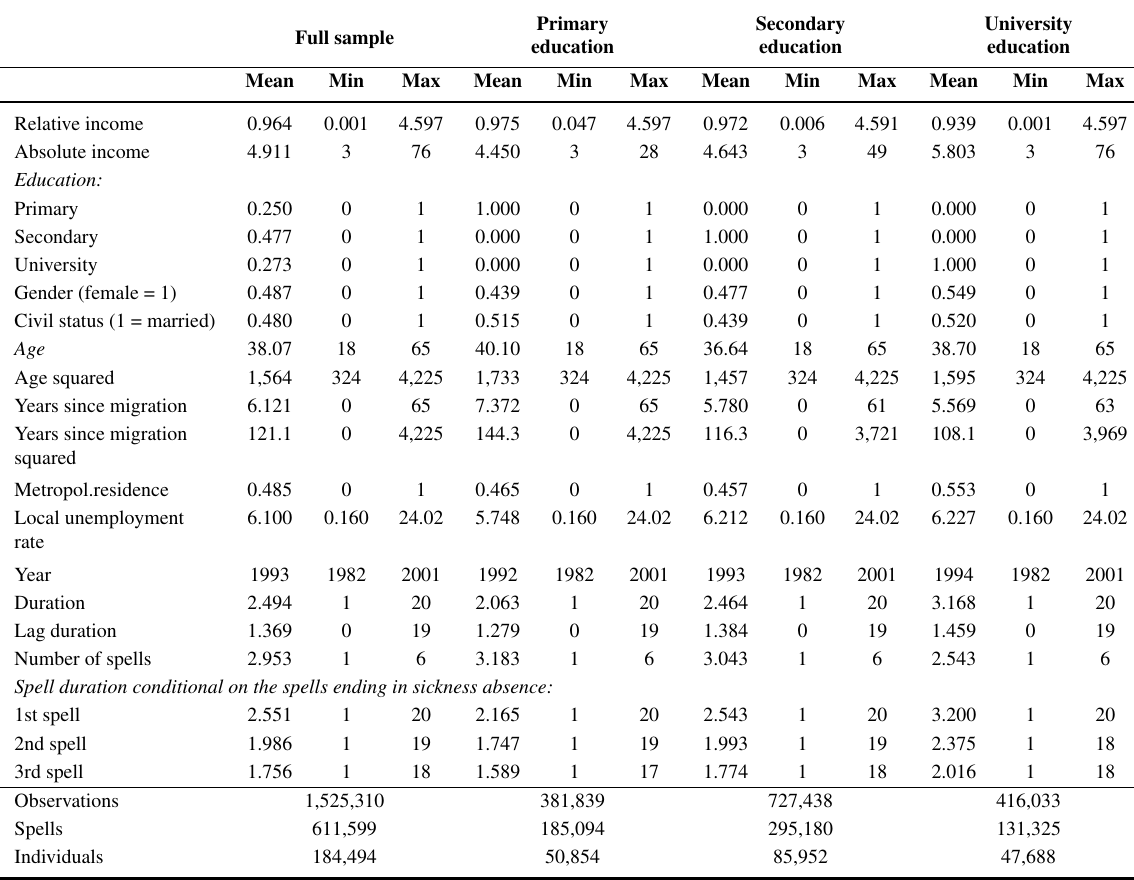
Table 1. Descriptive statistics: full sample and grouped by educational